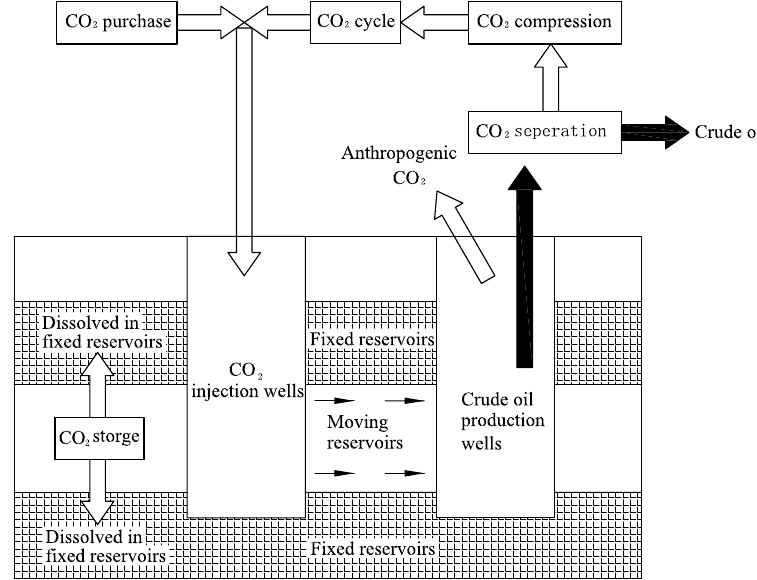
Figure 10. CO sequestration schematic 2